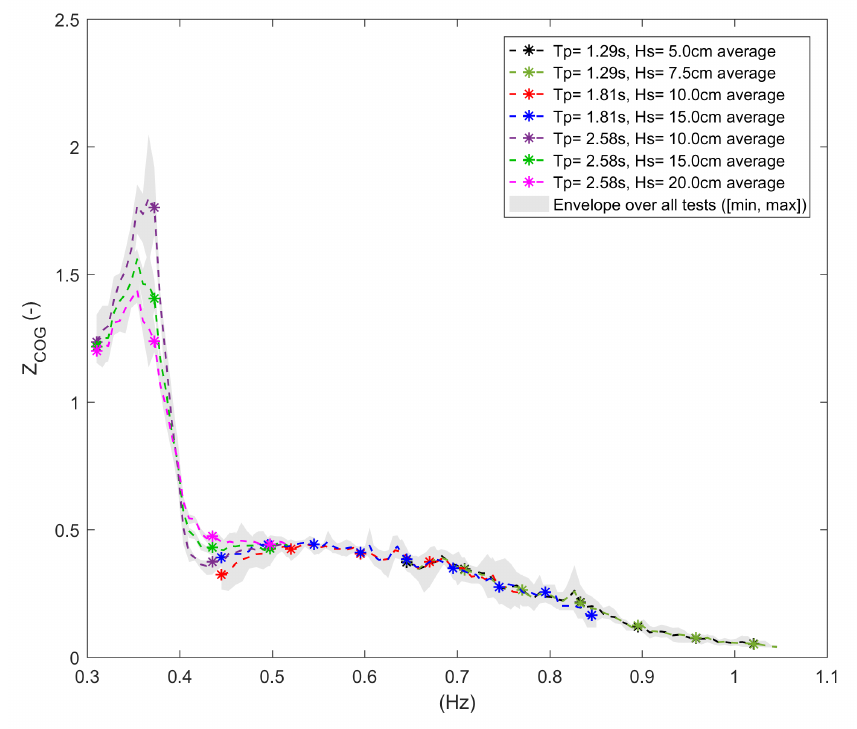
Figure 15. Surge RAOs for all JONSWAP waves: average and envelope (min and max).